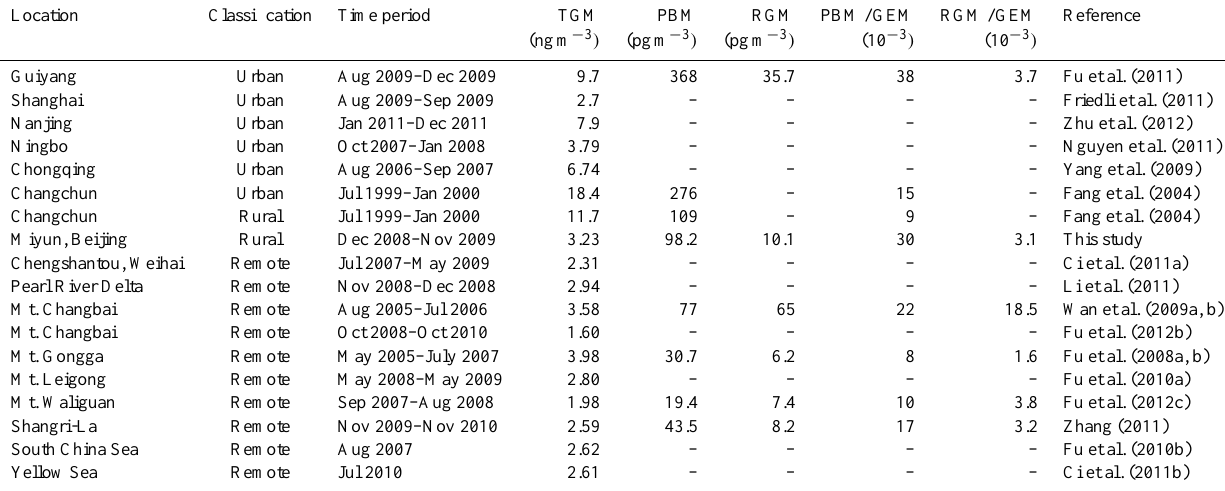
Table 2. Summary of atmospheric speciated mercury concentrations in China. Location Classification Time period